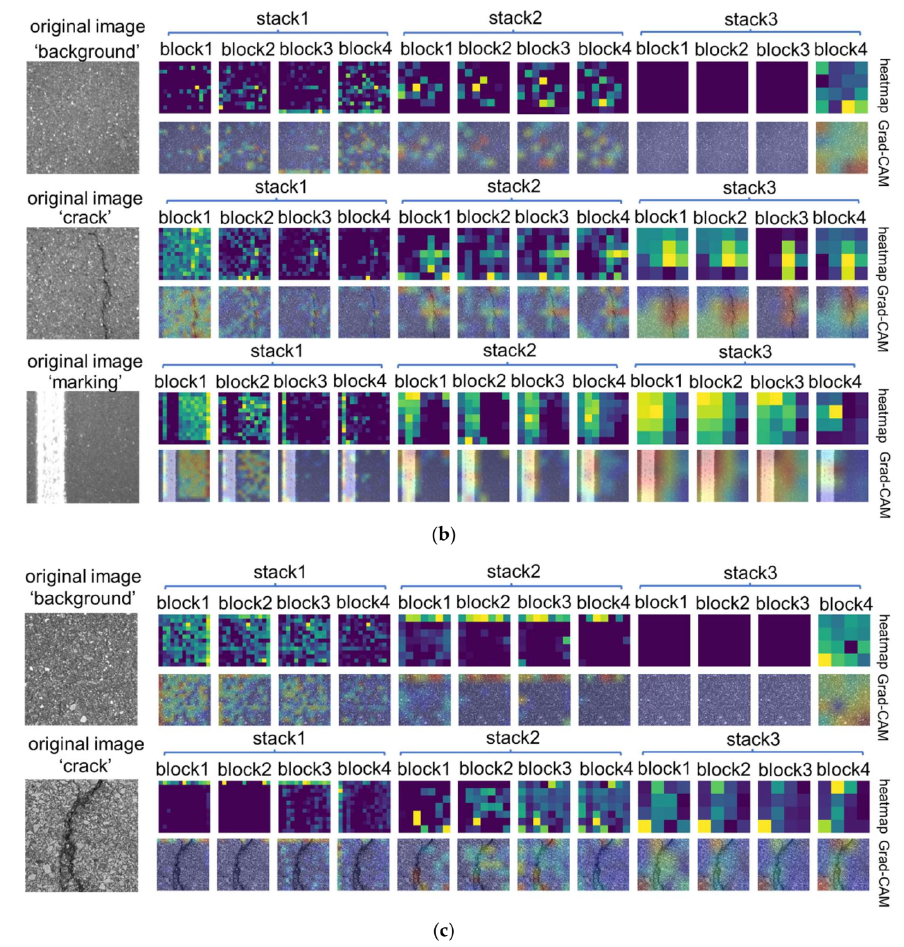
Figure 14. The heat maps and Grad-CAM images of different classifications in different datasets.